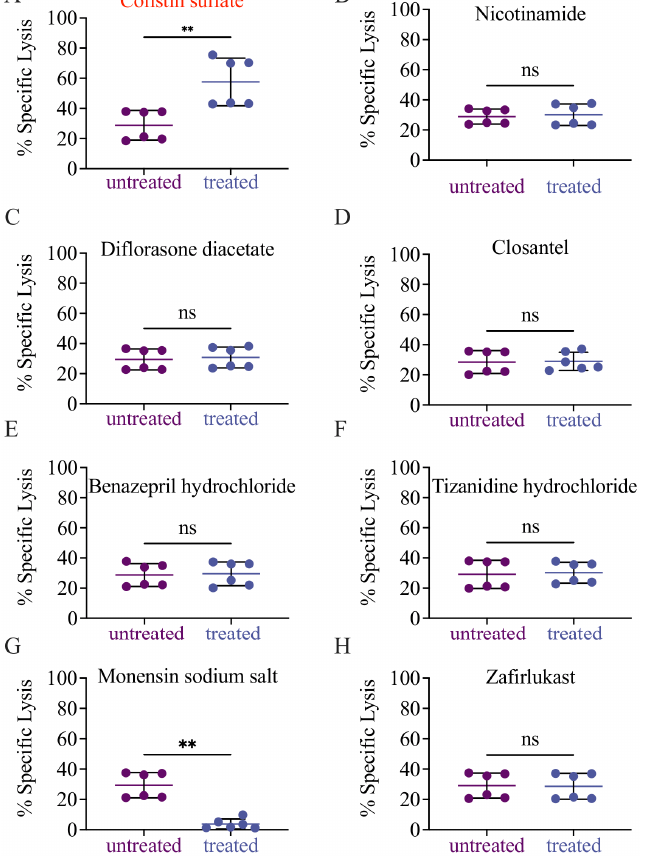
Figure 4. Colistin sulfate salt increases NK92 cytotoxicity against K562-NL. NK92 and K562-NL cells were seeded into a 96-well V bottom plate at a 1:1 or 3:1 E:T ratio with 10,000 K562-NL cells per well and treated with 1, 5, 10, and 20 μ M of the indicated drug for 5-h at 37 °C. After incubation, the supernatant